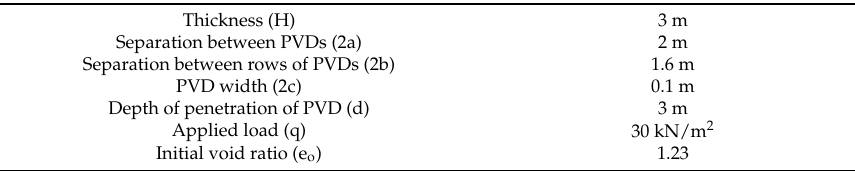
Table 1. Geometry of the problem and soil